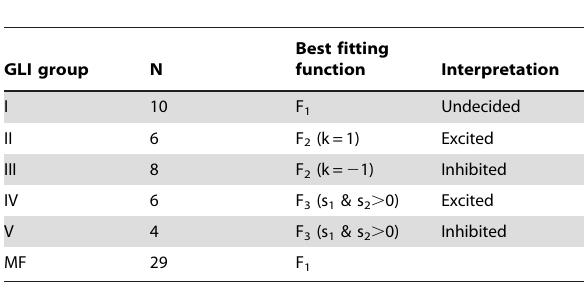
The first column indicates the GLI type (last row been mossy fibers [MF]). The second column indicates the number of unit recorded. The third column shows the chosen fitting functions F 1 - F 3 . The fourth column the interpretation, based on the model fit, of the net pathways connecting mossy fibers to GLIs (excitatory, inhibitory, or undecided).